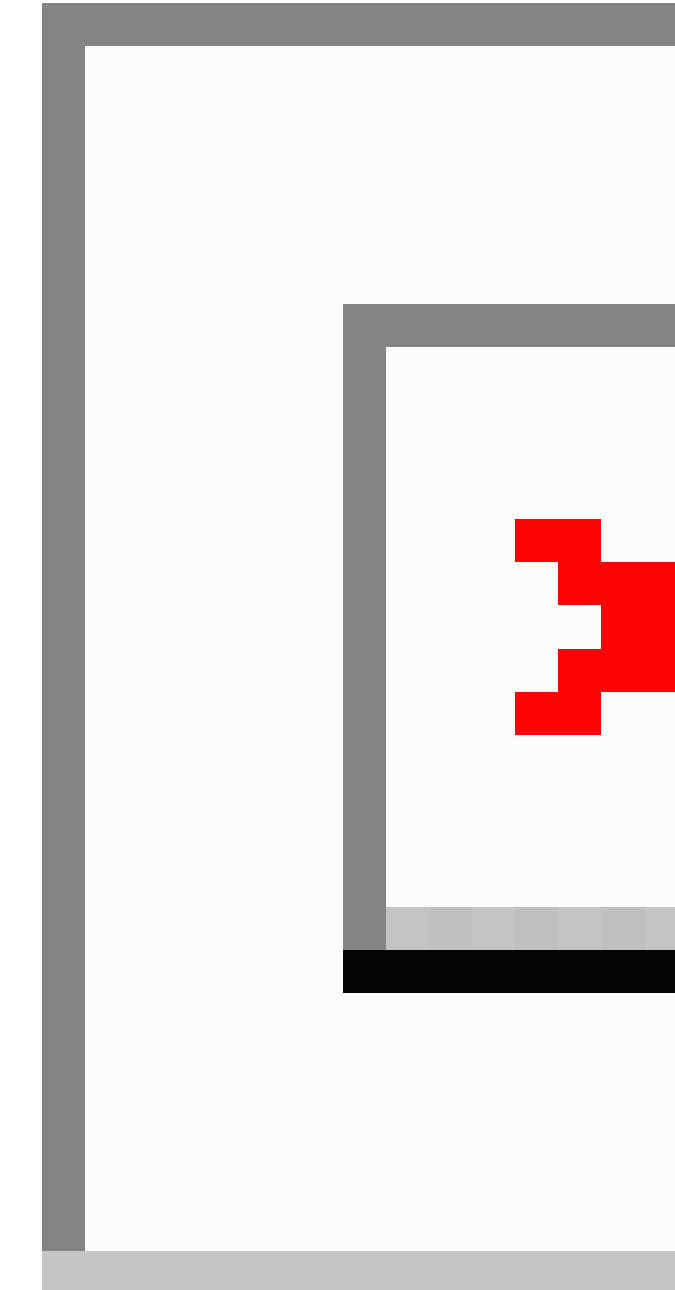
Figure 1. Histograms of frequency distribution for altmetric